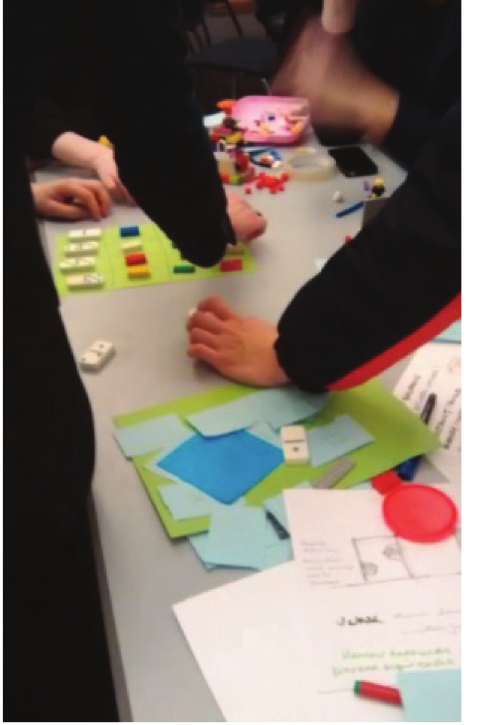
Figure 1: Participants within the game design workshop prototyping initial game